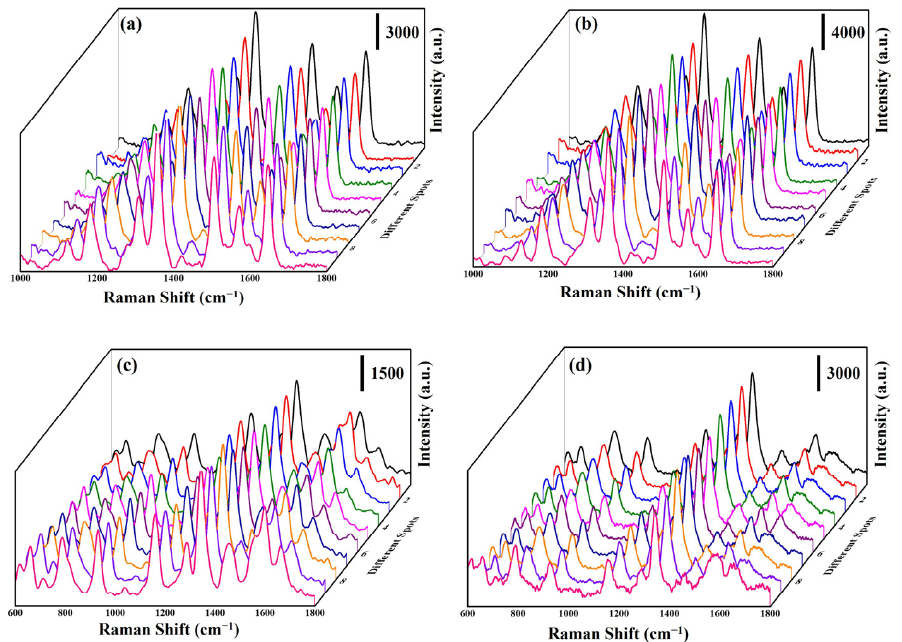
Figure 8. SERS spectra of (10 − 6 M) R6G solution at 10 random points on ( a ) ZnO: Ga@Ag nanotowers and ( b ) ZnO: Ga@ITO@Ag nanotowers. SERS spectra of (10 − 3 and 10 − 6 M) amoxicillin solution at 10 random points on ( c ) ZnO: Ga@Ag nanotowers and ( d ) ZnO: Ga@ITO@Ag nanotowers, respectively.